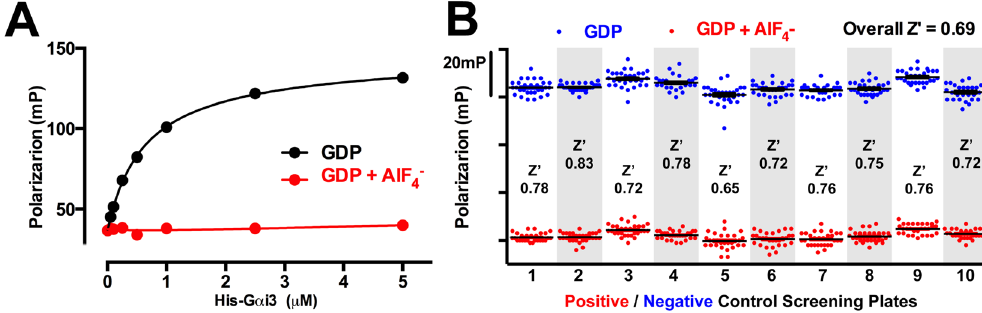
Figure 3. Assessment of the suitability of a Fluorescence Polarization (FP) assay for measuring G α i3-GIV binding in a high-throughput format. ( A ) The GTP mimetic GDP + AlF 4 − blunts the G α i3:GIV interaction as determined by FP. Binding of purified His-G α i3 to the fluorescently-labeled GIV 1671–1701 peptide was determined as in Fig. 2C in the presence of GDP (black) or GDP + AlF 4 − (red). Increasing concentrations of purified His-G α i3 (0.125–10 µ M) were incubated with the peptide (25 nM). Fluorescence polarization (FP) data were fit to a one-site binding model. One representative experiment out of three is shown. ( B ) Scatter plot of positive and negative control data points and Z’ determination for the G α i3:GIV 1671–1701 peptide binding FP assay. FP measurements were carried out in a 384-well format in ten independent plates for an equal number of wells with assay buffer containing GDP alone (blue, negative controls) or GDP + AlF 4 − (red, positive